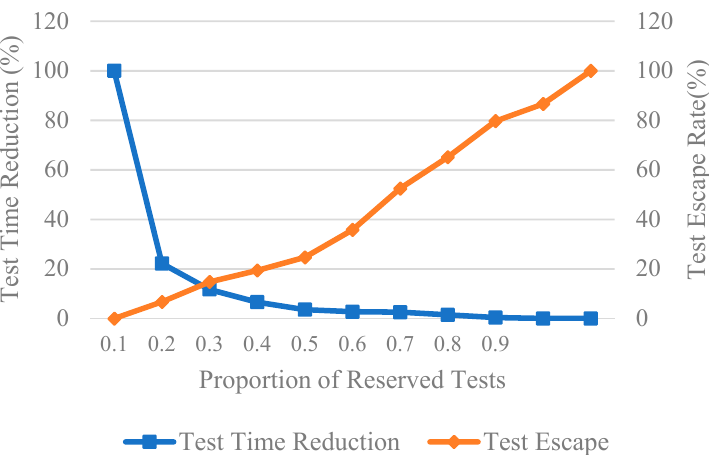
Figure 8. The result in different reserved proportions.